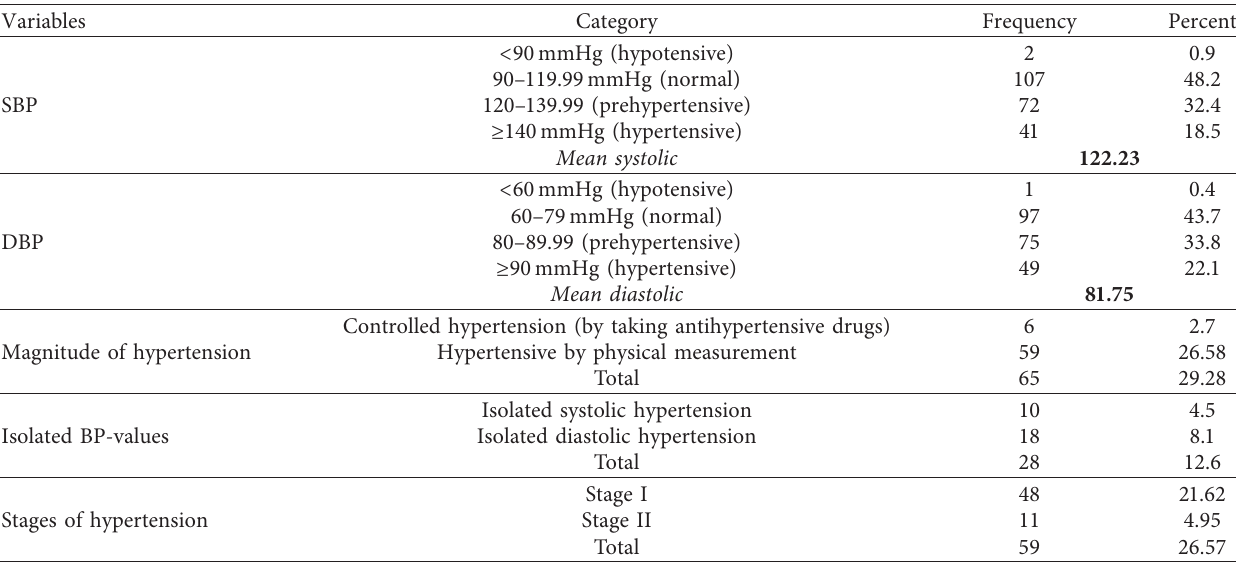
Table 2: Distribution and classification of blood pressure in the study population, Bahir Dar, northwest Ethiopia, January 2020 ( n � 222).